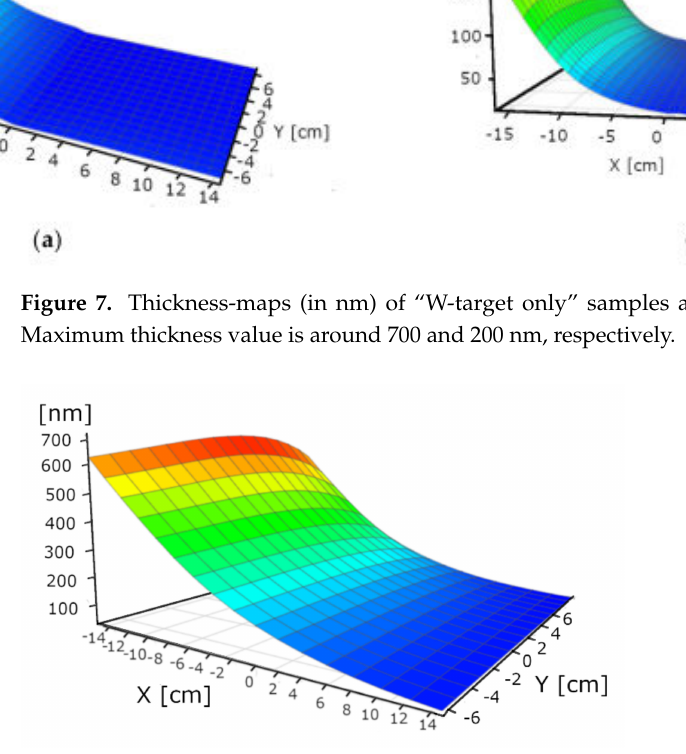
Figure 8. Thickness-map (in nm) of “Mo-target only” sample at 1 kW power. Maximum thickness value is around 700 nm, which corresponds to the W maximum